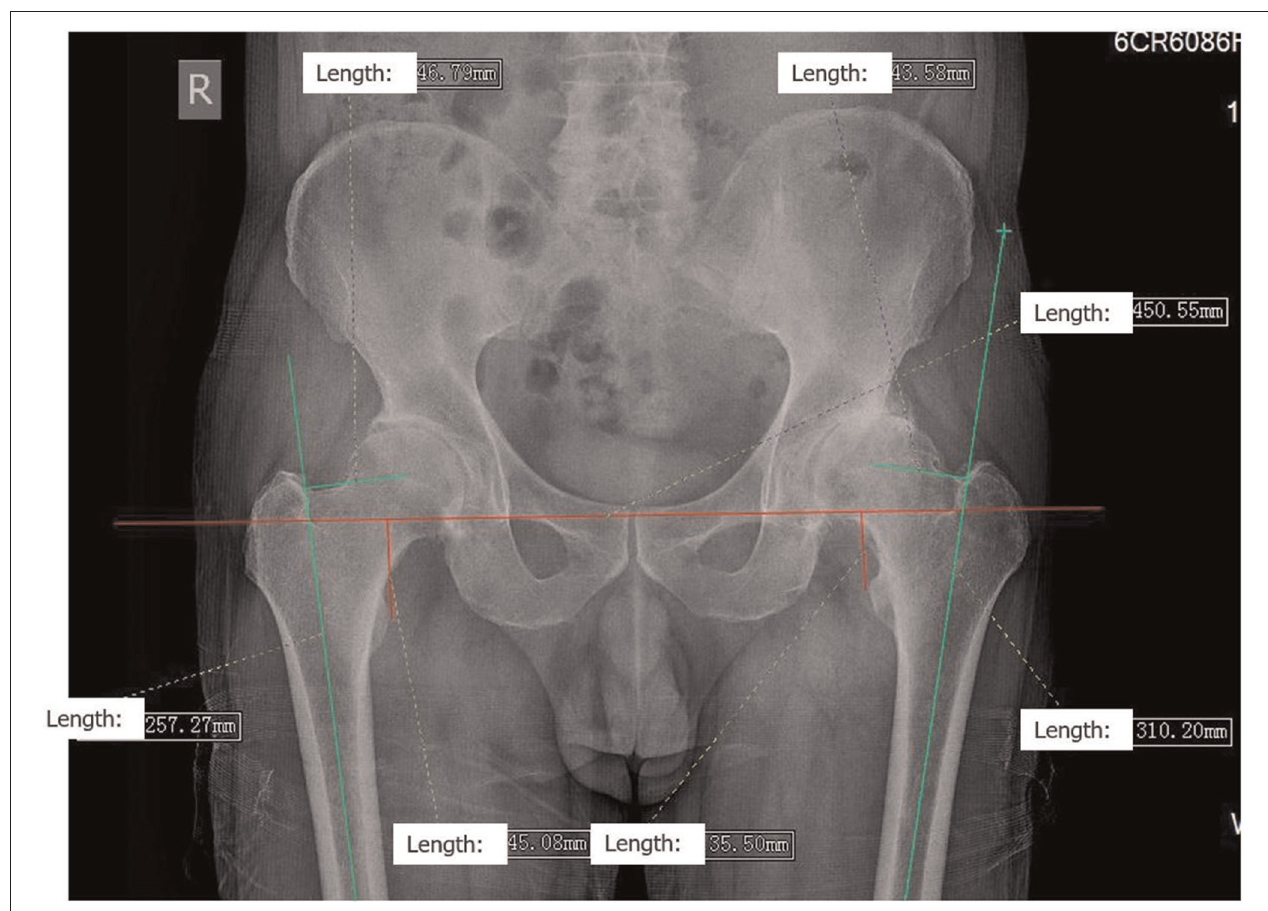
FIGURE 1 | Preoperative X-ray templating All data measurements were made on Neusoft PACS. An anteroposterior (AP) positive view of the pelvis was obtained with both lower extremities internally rotated at 15 ◦ . For LLD measurement, a reliable method is to measure the vertical distance from the line connecting the lower edge of the two teardrops to the innermost edge of the small rotor. The difference between the measured values of the two sides is the LLD. OD is measured by the distance between the axis of the femur and the center of the femoral head. In the figure, the LLD was 9.58mm, the OD on the right was 46.79mm, and the OD on the left was